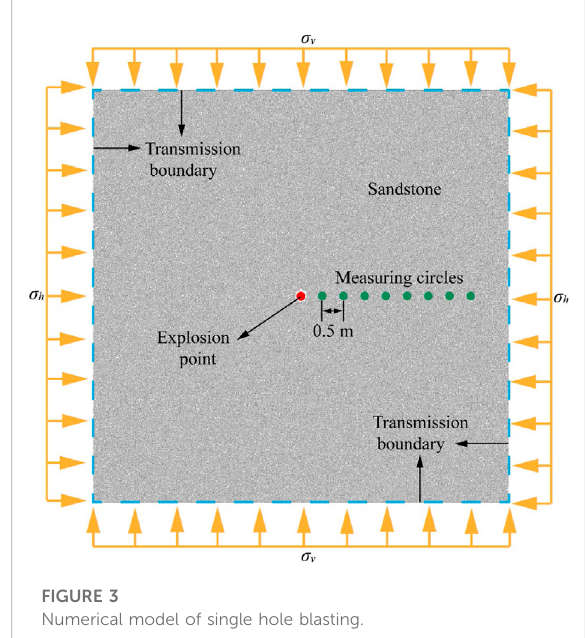
FIGURE 3 Numerical model of single hole